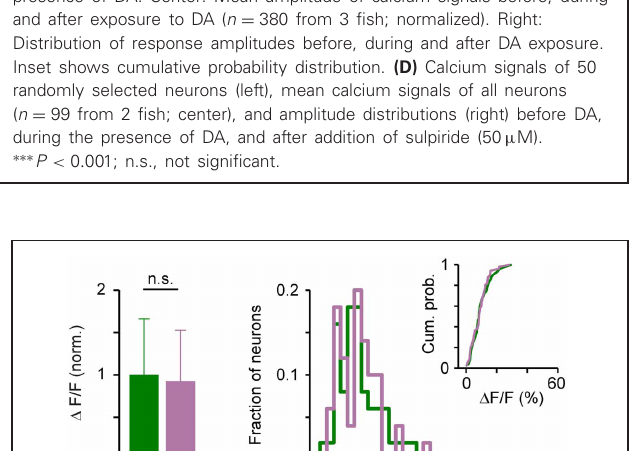
FIGURE 8 | Effects of sulpiride on population activity patterns in Dp evoked by electrical stimulation of the olfactory tract. Left: Mean amplitude of calcium signals before and during exposure to sulpiride ( n = 50 neurons from 2 fish; normalized). Right: distributions of calcium signal amplitudes; inset shows cumulative probability distribution. No statistically significant differences were detected between means or